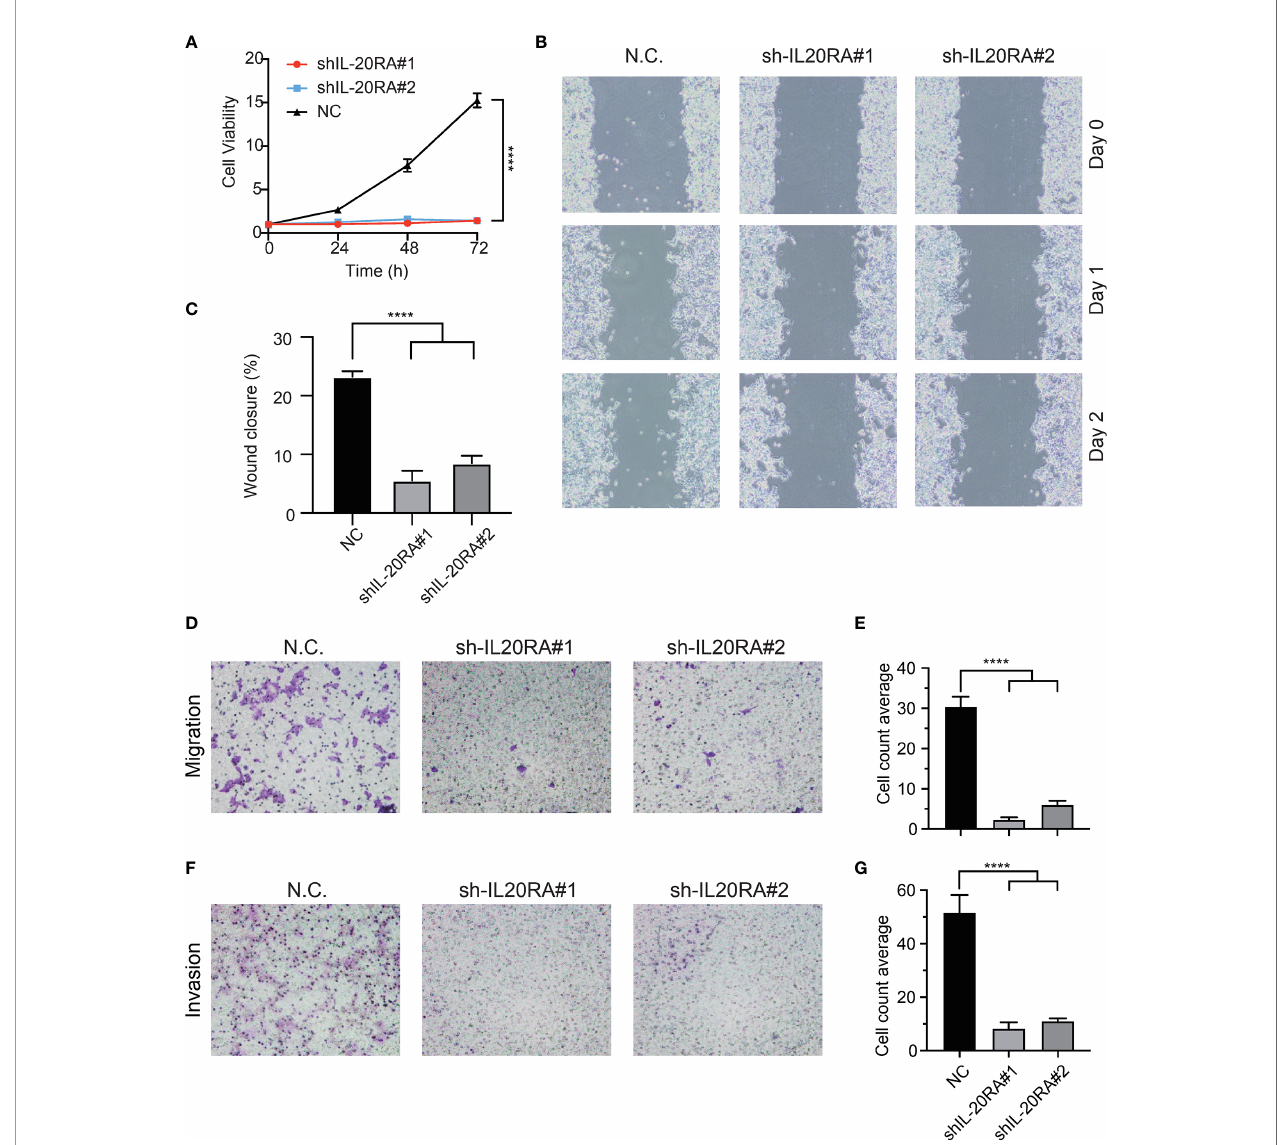
FIGURE 5 | Knockdown of IL-20RA inhibited the growth and metastasis of colorectal cancer cells. (A) Cell proliferation of shIL-20RA was decreased in LoVo cells. Cell viability was detected at 0, 24, 48, and 72 hours by CCK-8 assay. (B, C) Wound healing assay of shIL-20RA in LoVo cells. Healing ability was decreased with shIL-20RA. The images were photographed at 0, 24, and 48 hours. (D, E) The migration ability of LoVo cells treated with shIL-20RA was decreased as shown by Transwell analyses. The number of migrated cells was counted under the average of 5 random fi elds. (F, G) The invasion ability of LoVo cells treated with shIL-20RA was decreased as shown by Transwell analyses. The number of invasive cells was counted under the average of 5 random fi elds. ****P <